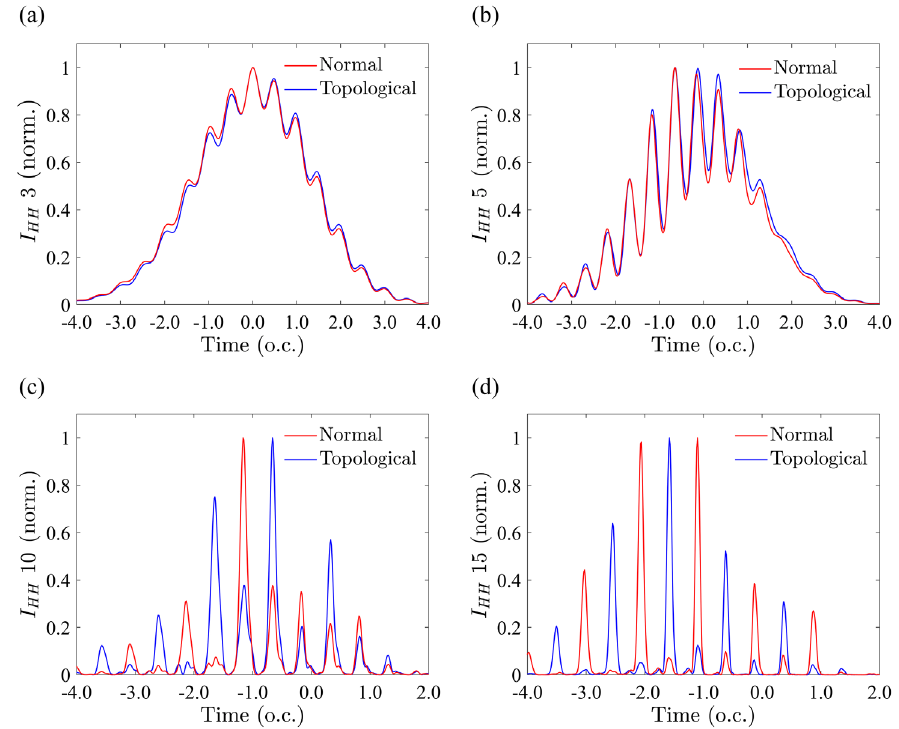
FIG. 12. HHPTs of the (a) 3th, (b) 5th, (c) 10th, and (d) 15th orders for the NP and TP phase points in the KM model. The laser condition is the same as in Fig.